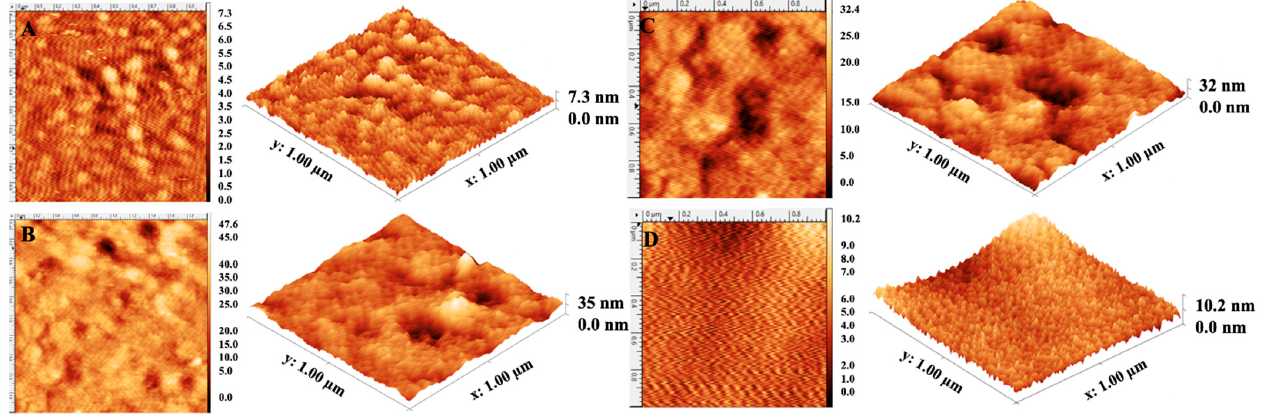
Figure 2. Two- and three-dimensional AFM images of the bare ( A ), AuNP-MIP ( B ), MIP ( C ), and AuNP-NIP ( D ) plasmonic sensors to show surface topographies.